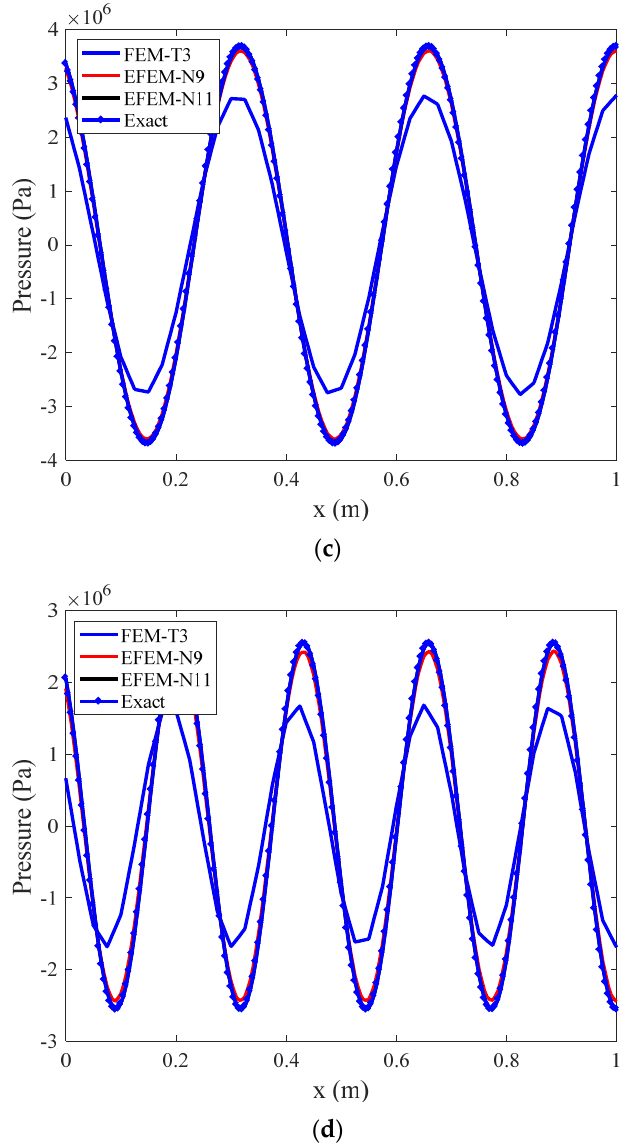
Figure 5. The calculated acoustic pressure provided by various numerical techniques for di ff erent frequency values: ( a ) f = 1100 Hz; ( b ) f = 2200 Hz; ( c ) f = 4400 Hz; ( d ) f = 6600 Hz.